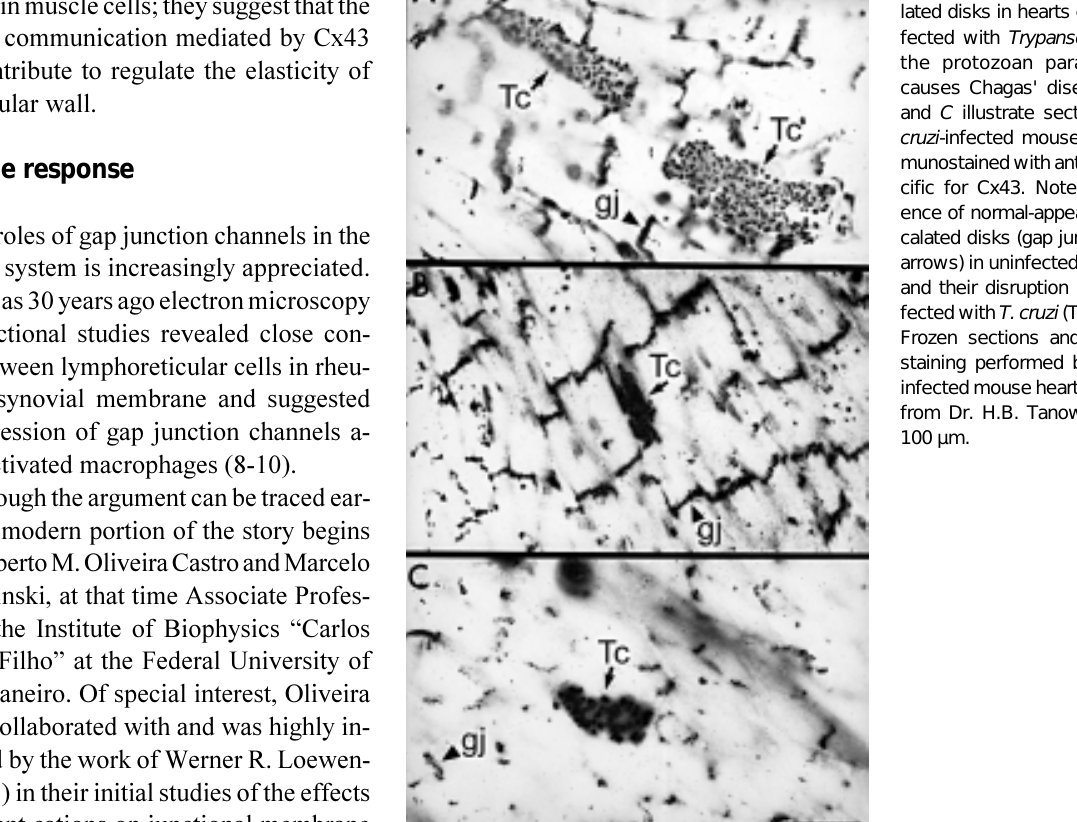
Figure 2 - Disruption of interca- lated disks in hearts of mice in- fected with Trypansoma cruzi , the protozoan parasite that causes Chagas' disease. A , B and C illustrate sections of T. cruzi- infected mouse heart im- munostained with antibody spe- cific for Cx43. Note the pres- ence of normal-appearing inter- calated disks (gap junctions: g j , arrows) in uninfected myocytes and their disruption in cells in- fected with T. cruzi (Tc, arrows). Frozen sections and immuno- staining performed by C.